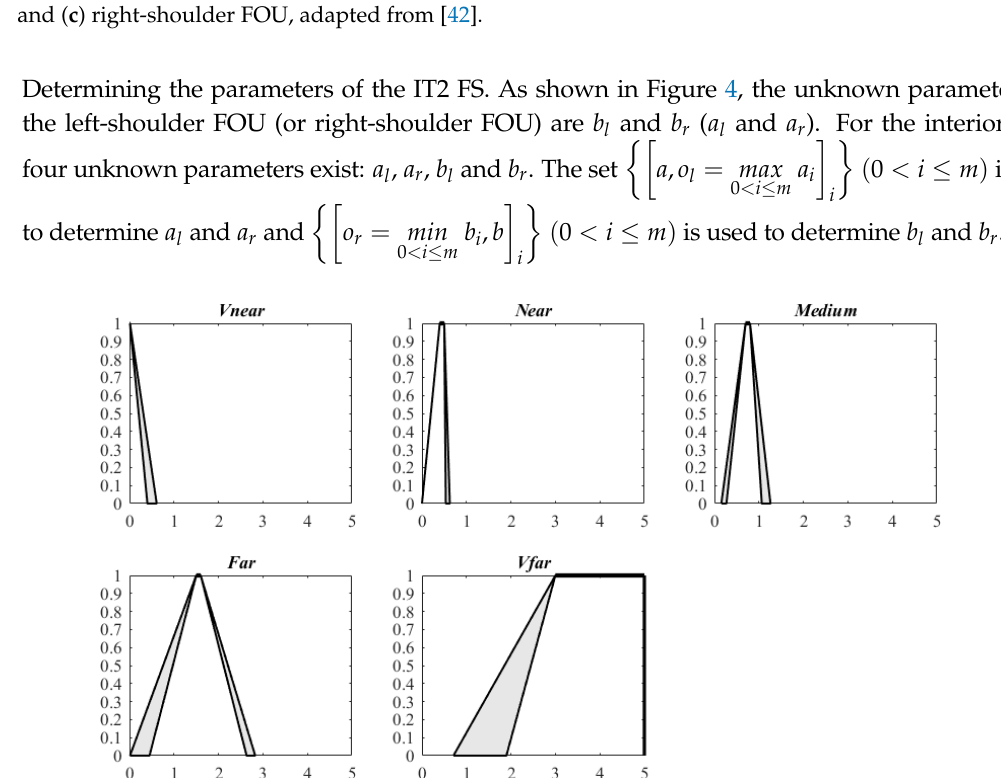
Figure 4. IT2 FSs of five qualitative distance words for walk (unit: km).